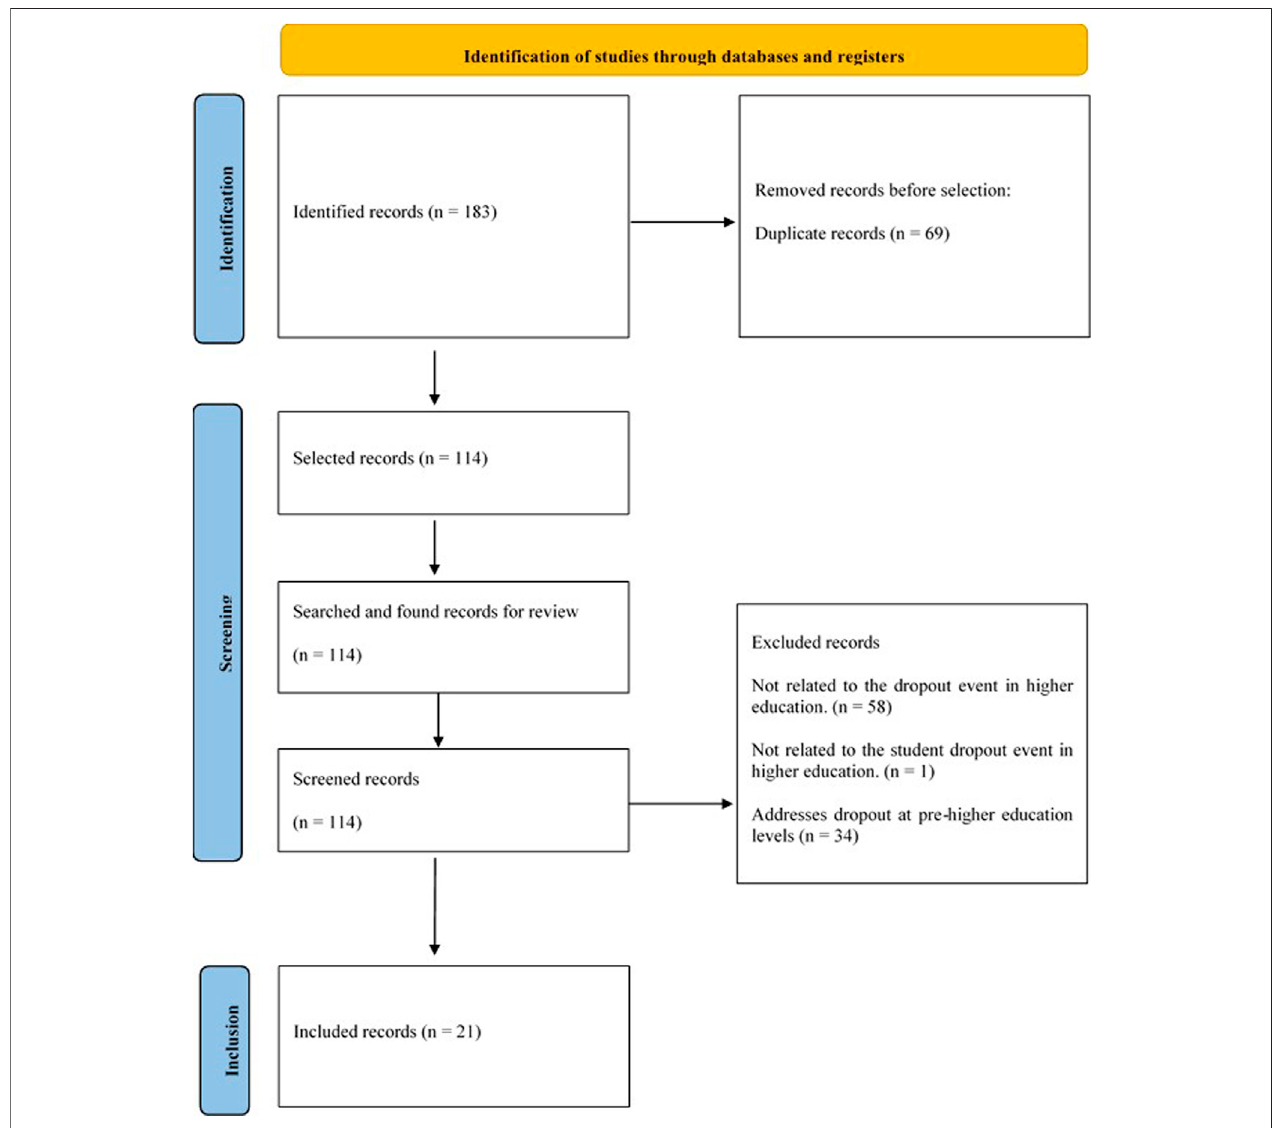
FIGURE 2 | PRISMA 2020 method fl ow chart. Adapted from (Page et al.,